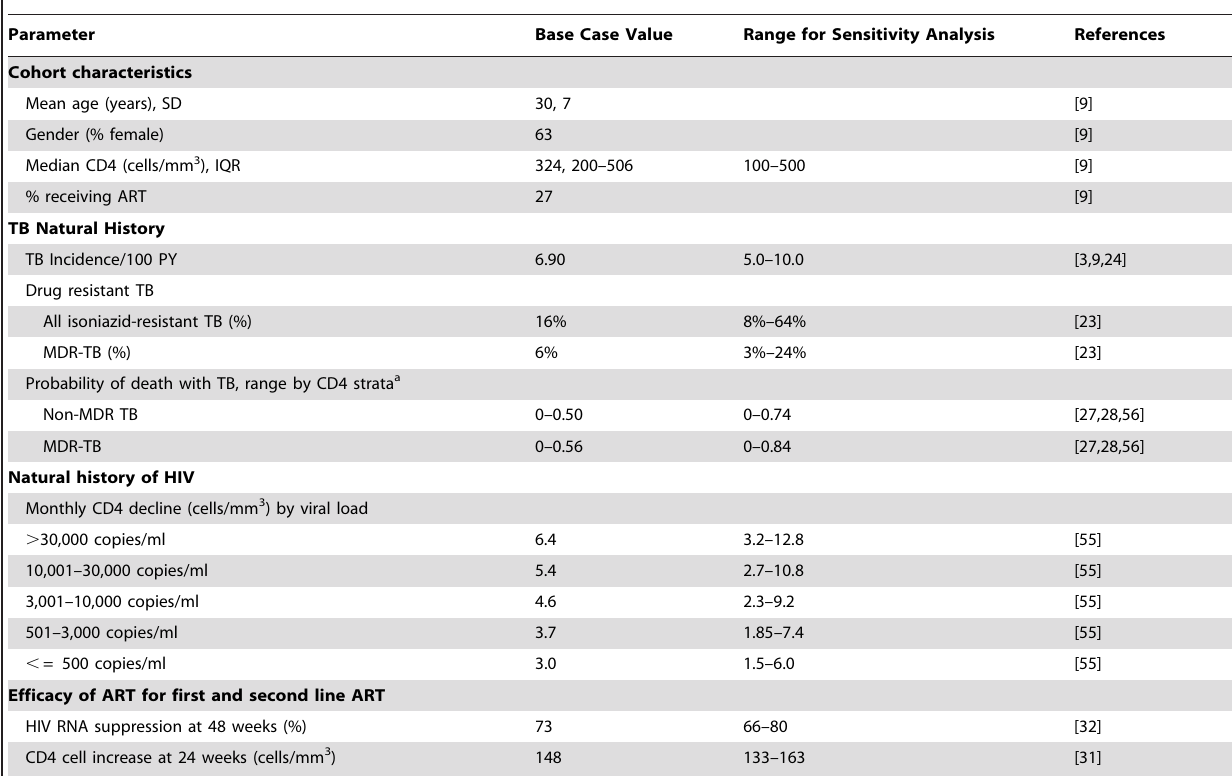
Table 1. Baseline cohort characteristics, TB and HIV natural history, HIV treatment parameters.